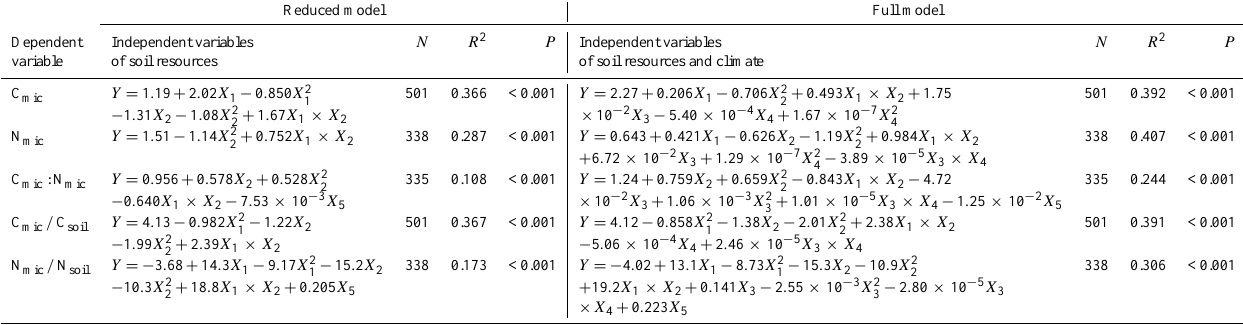
Table 1. Multiple regression models of microbial biomass carbon (C mic ) , microbial biomass nitrogen (N mic ) , C mic :N mic ratio, and microbial quotients (i.e., C mic / C soil and N mic / N soil rates) against soil resources and climate. C soil and N soil stand for soil organic carbon and soil total nitrogen, respectively. Y , X 1 , X 2 , X 3 , X 4 , X 5 in the models stand for the dependent variable, C soil , N soil , mean annual temperature, mean annual precipitation, and C soil :N soil ratio, respectively. Y , X 1 and X 2 are 10-based log transformed. N , R 2 , P stand for sample size, determination coefficient, and probability, respectively. All the terms in the regression models are significant at α = 0.05. Reduced model Full